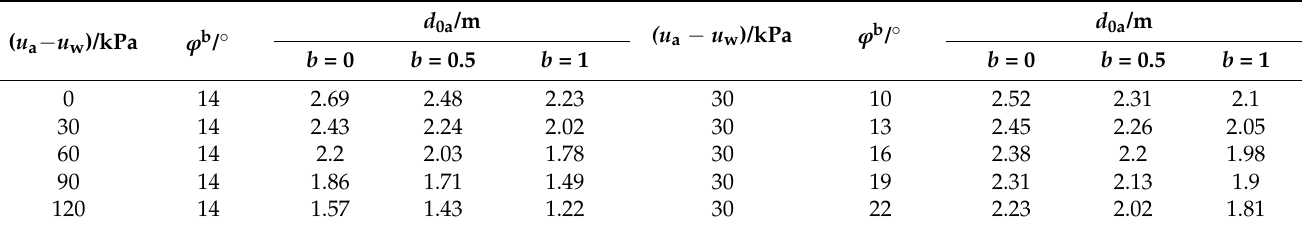
Table 4. Resultant location of Rankine active earth pressure and unsaturation